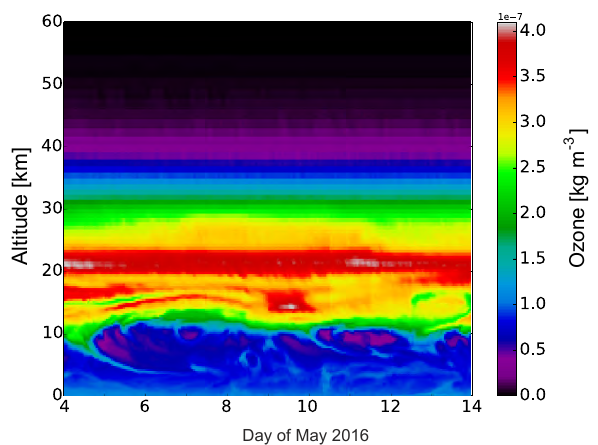
Figure 9. Ozone density from the ground to 60km altitude above Kühlungsborn on 4–13 May 2016 derived from